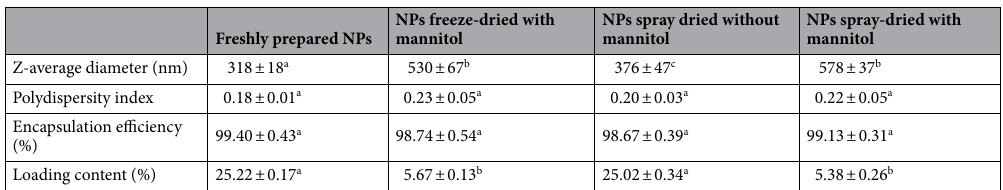
Table 1. Physicochemical properties of freshly prepared and reconstituted NPs (one way ANOVA comparisons, p < 0.05).